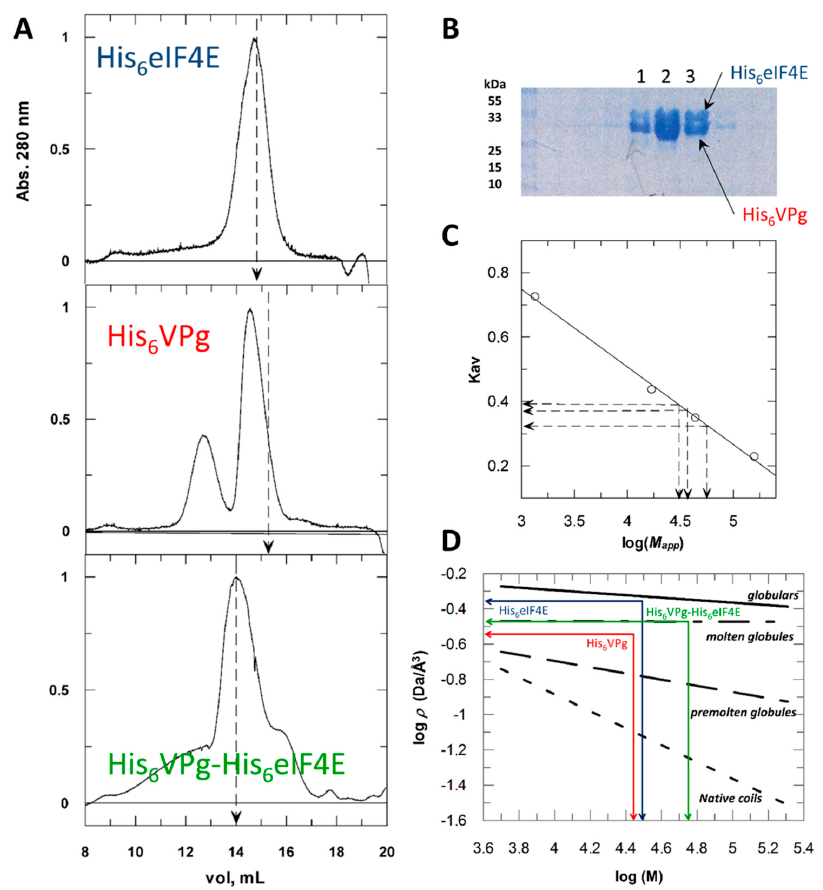
Figure 1. Size exclusion chromatography of His 6 tagged VPg, His 6 tagged 4E (eIF4E) and His 6 VPg-His 6 eIF4E, their binary complex. ( A ) Separated runs of the purified monomers (1 mL of 0.7–1 mg/mL) were performed. Vertical dashed lines refer to the elution volumes expected for globular proteins of 28,549 Da (upper panel) and 26,137 Da (middle panel), the molecular weights of recombinant His 6 eIF4E and His 6 VPg respectively (MALDI-TOF spectrometry determinations). The His 6 VPg-His 6 eIF4E binary complex was pre-formed by mixing His 6 eIF4E (0.7 mg/mL with an excess of His 6 VPg (1.2 mg/mL) and loaded up to the column (lower panel). A mass of 54,772 Da was estimated for the binary complex (summing His 6 VPg and His 6 eIF4E molecular weights) vertical dashed line. For comparison, absorbance values were standardized to the maximum value of each peak. ( B ) Distribution of the various molecular species through the size exclusion chromatography (SEC) separation of a His 6 VPg-His 6 eIF4E mix. Upon elution, fractions 1. 2 and 3 were recovered and submitted to SDS-PAGE analysis. ( C ) Determination of the three molecular species apparent molecular weights ( M app ) deduced from standard calibration with a set of known globular proteins. K av is a mean value determined from at least three independent SEC runs. ( D ) Apparent molecular densities ( ρ ) of the three molecular species were deduced from their experimentally determined hydrodynamic radius ( R h ) values (see material and methods). For each protein, the intersection between log ρ and log( M ), M being the true molecular mass, allows to deduce the conformational families to which they belong to. Because SEC leads to proteins diluting and to complexes partly dissociating during the chromatography process, it required substantial amount of proteins at concentration above 0.5 mg/mL. We experienced difficulties to obtain isolated untagged VPg and eIF4E at the concentrations